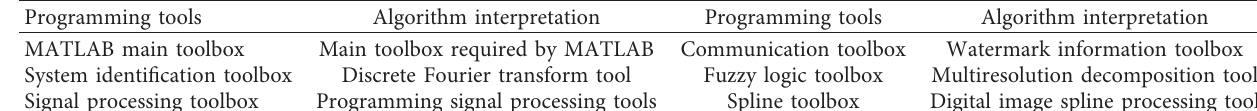
Table 1: MATLAB programming parameters.